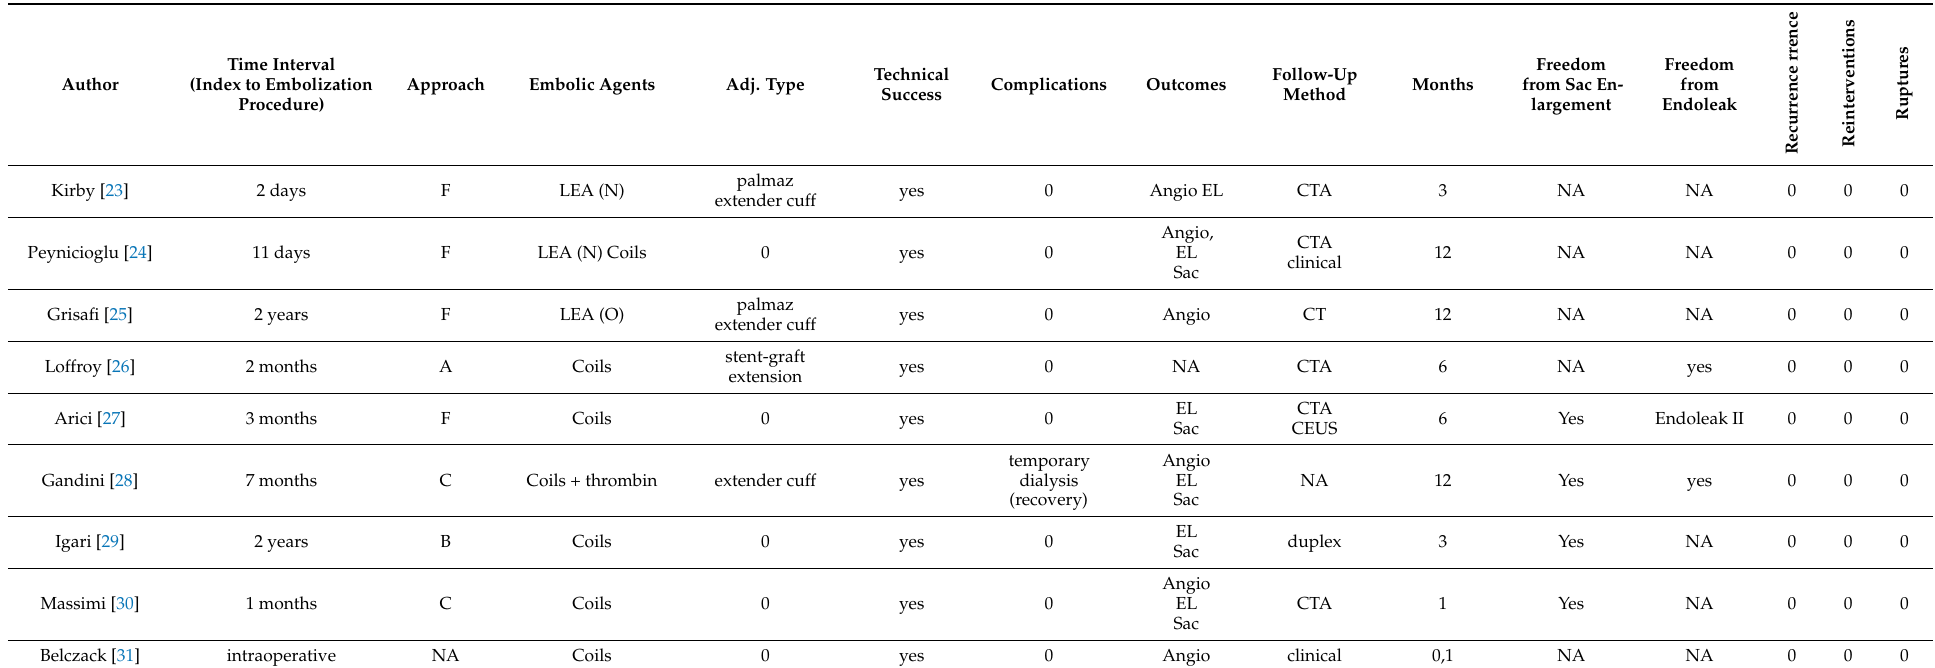
Table 4. Case reports: embolization procedure characteristics, technical success and